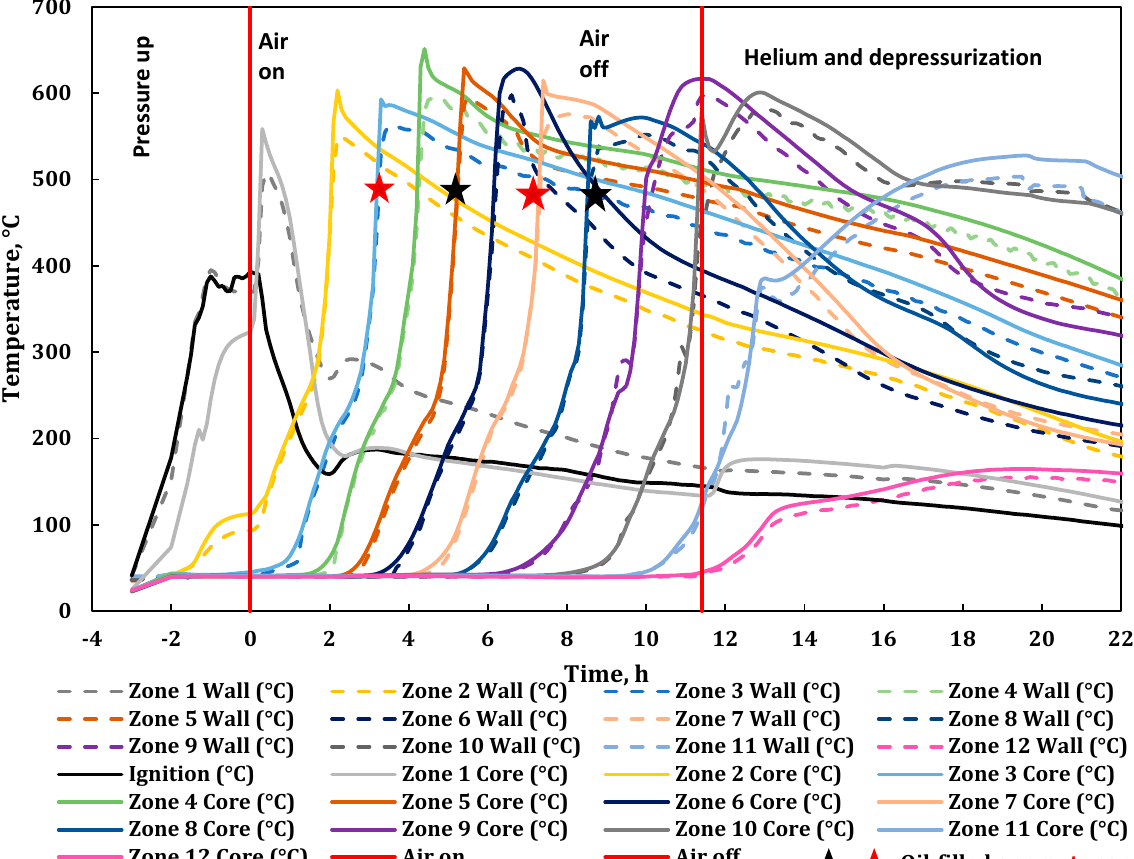
Figure 6. Temperature profile—vuggy test.